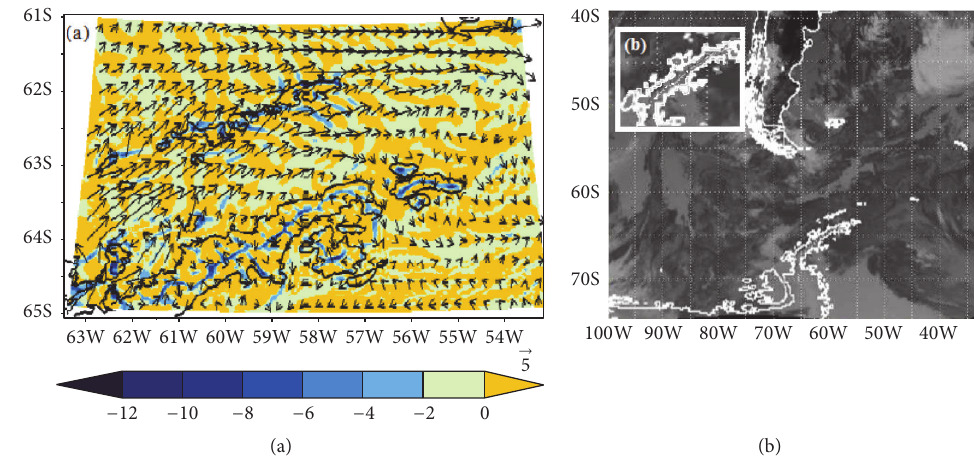
Figure 8: The same as in Figure 6, but for 31 December 2014, model output at 18:00 UTC and satellite image at 17:45 UTC.